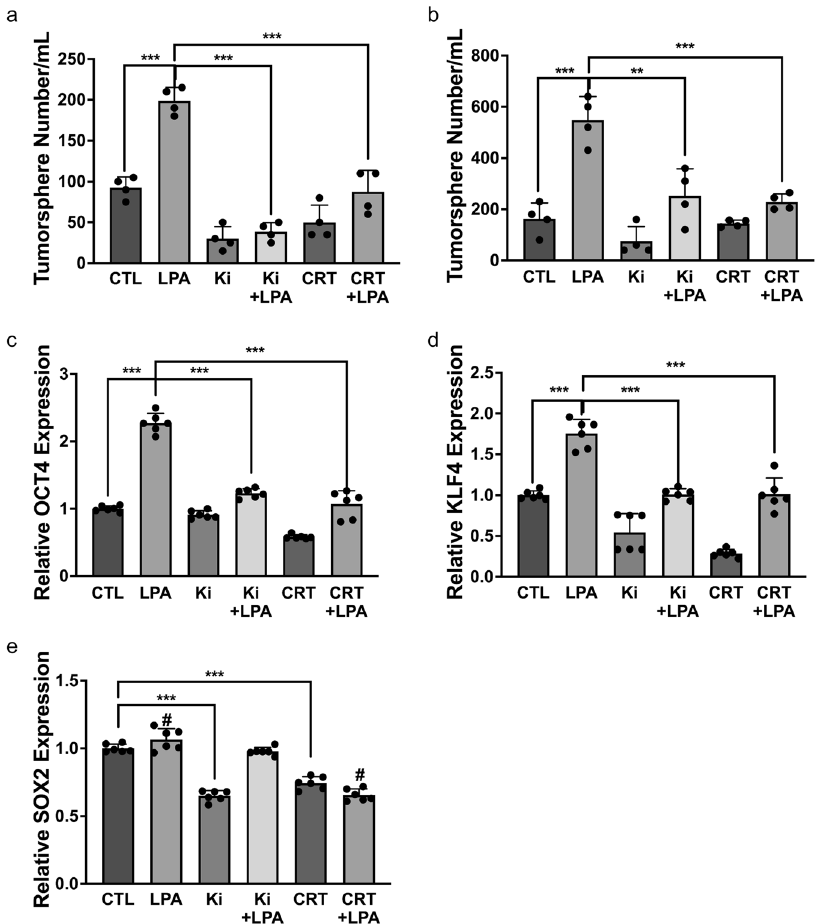
Fig. 5 LPA-PKD-1 signaling in breast cancer stemness. a Tumorsphere formation of mouse BC cells. CD44 + E0771 cells were cultured in complete MammoCult ™ Medium with the treatment of 10 µ m LPA, 1 µ m CRT0066101 (PKD inhibitor), 1 µ m Ki16425 or their combination for 7 days. b Tumor